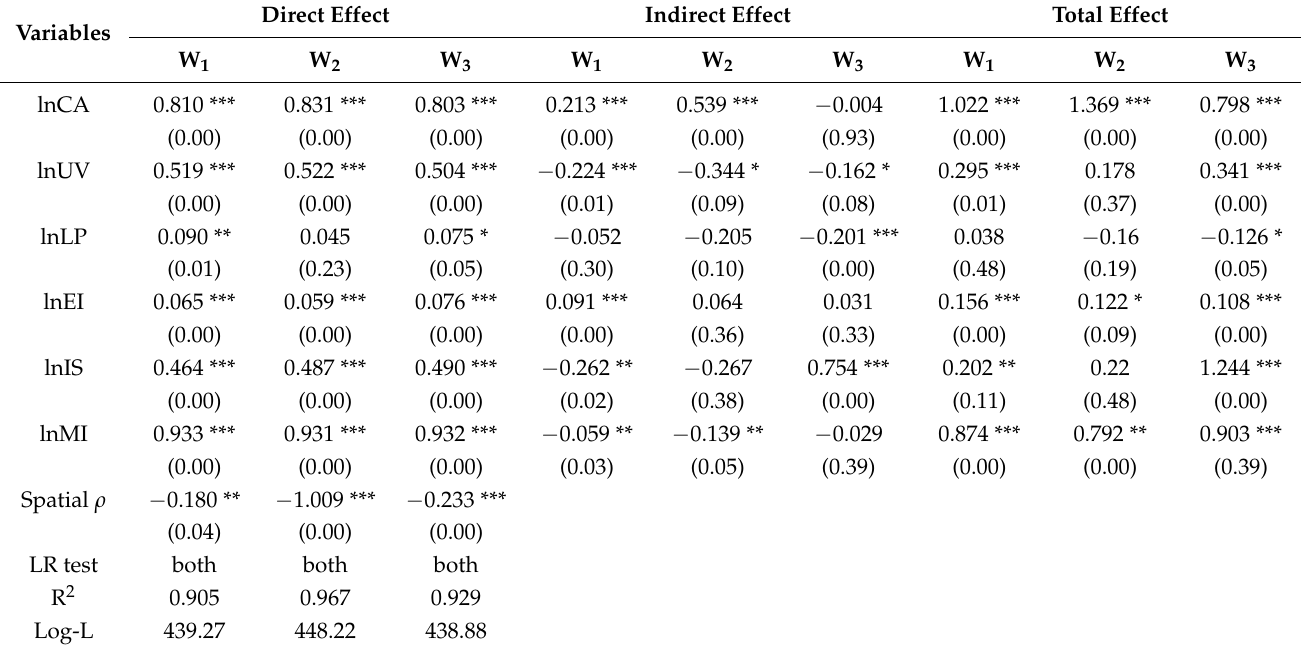
Table 6. Spatial panel regression results of the materialization